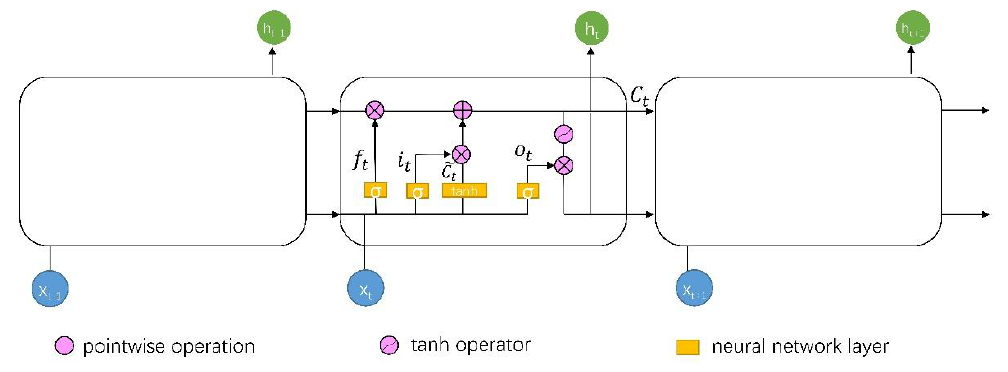
Figure 2. Structure of the LSTM network.